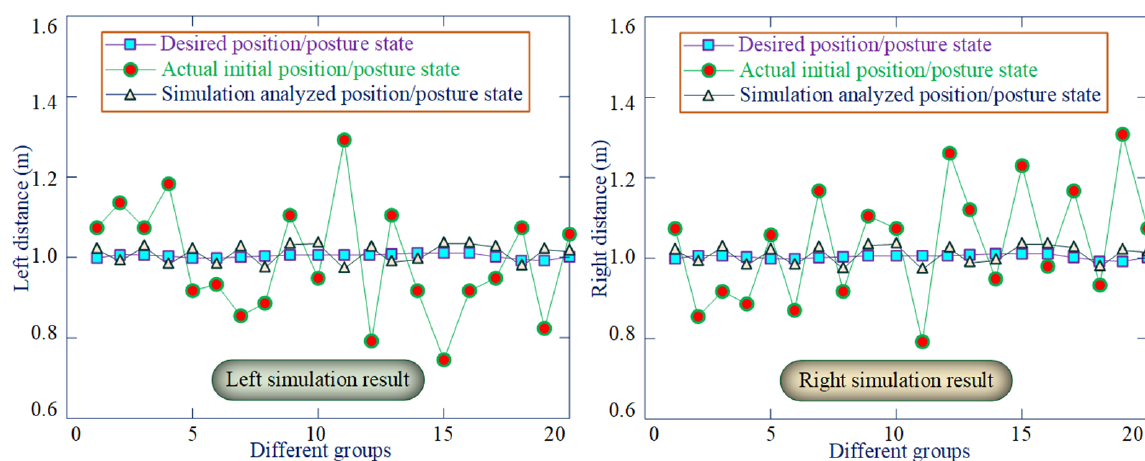
Figure 14. Simulation results of edge distances.